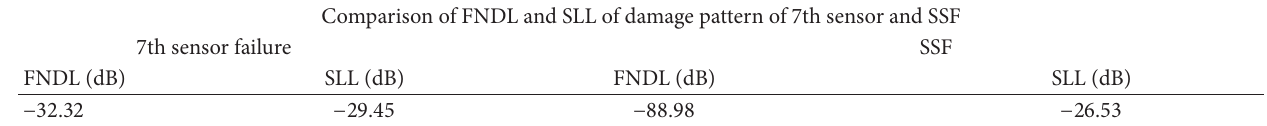
Table 2: Comparison of FNDL and SLL of the damaged pattern.